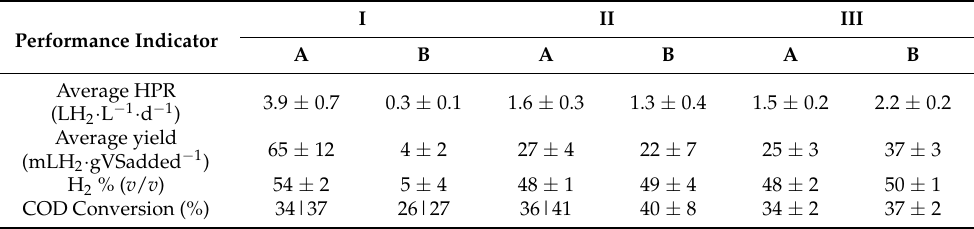
Table 2. Performances of the continuous fermentation in the periods I, II and III in conditions A and